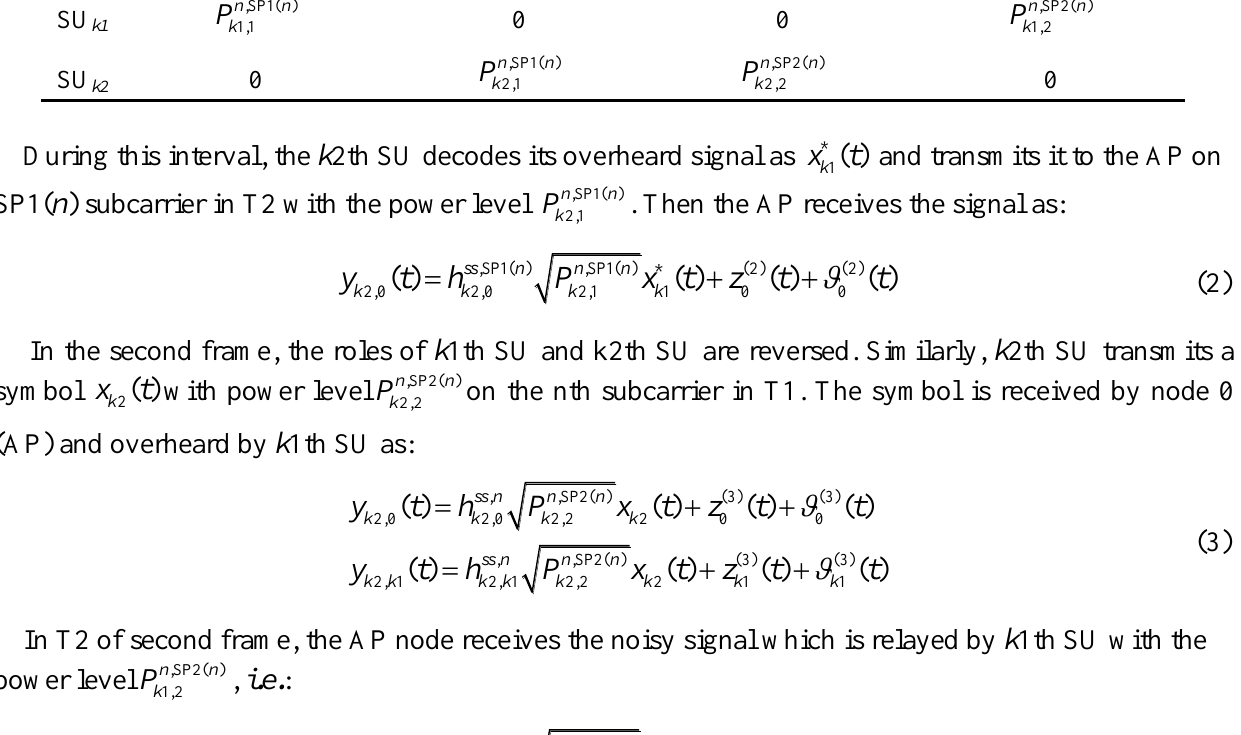
Table 2. Power allocation scheme for k th cooperative partner on subcarrier n . T1 in First Frame T2 in First Frame T1 in Second Frame T2 in Second